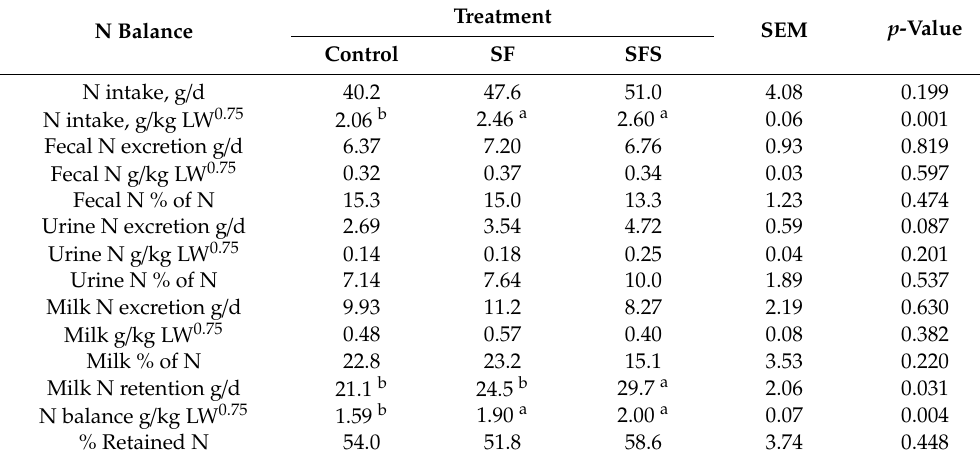
Table 4. Nitrogen balance (g N / d, g N / kgLW 0.75 ) in dairy sheep fed control, sunflower seeds (SF), and sunflower seeds silage (SFS)